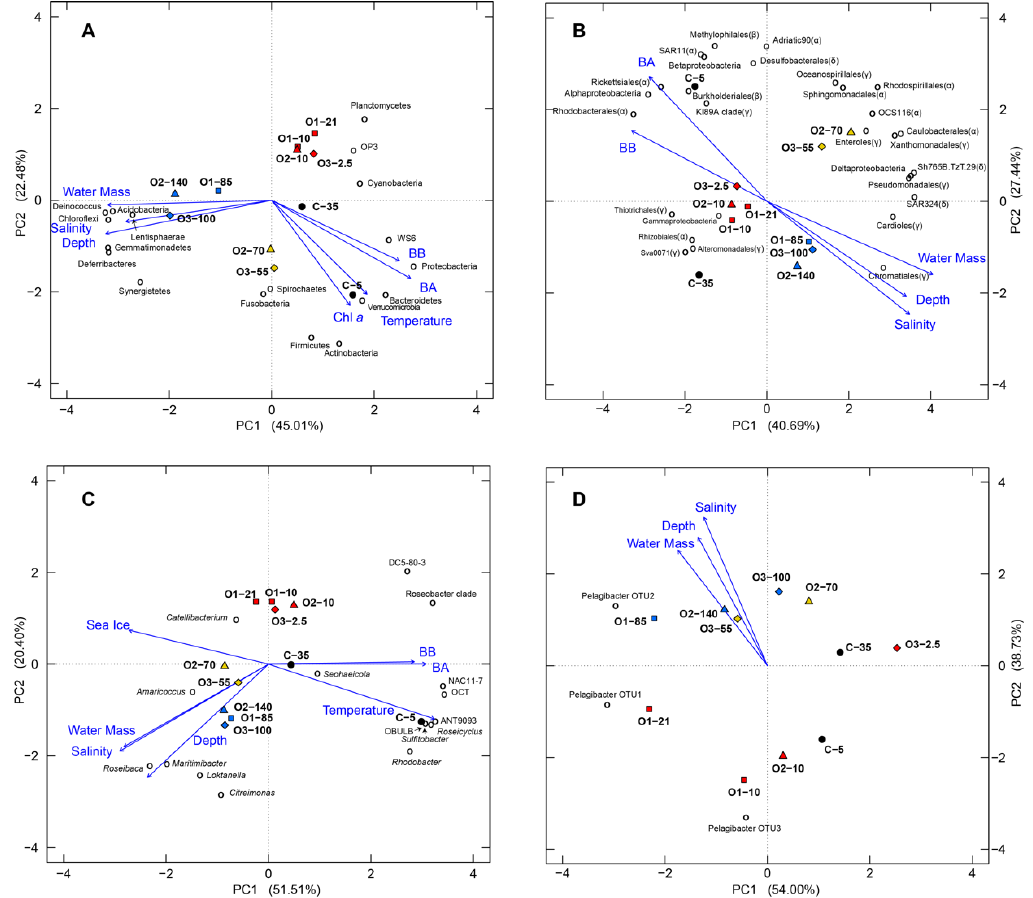
Figure 10. Principal component analysis (PCA) based on the relative proportions of taxonomic groups. Analyses are based on taxonomic levels of phyla ( A ), predominant classes and orders in the phylum Proteobacteria ( B ), major genera and lineages in the order Rhodobacterales ( C ) and the order Pelagibacterales ( D ). The open circles represent the taxonomic groups used for calculating the PCA ordinates and closed symbols represent the 11 samples. The closed symbols are colored according to water mass: red, UPML; yellow, LPML; blue, PSW; black, coastal. The shapes represent the different stations: C, circles; O1, squares; O2, triangles; O3, diamonds. Arrows indicate parameters that were significantly correlated with PC1 and/or PC2 (BA, bacterial abundance; BB, bacterial biomass).